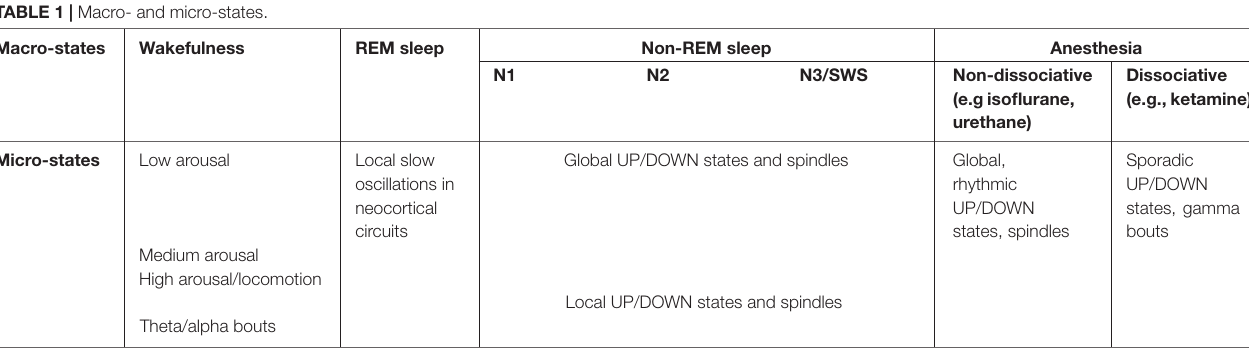
TABLE 1 | Macro- and